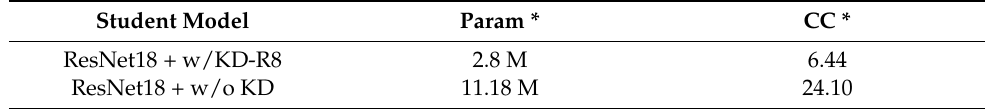
Table 7. Comparison model parameters and computational complexity.